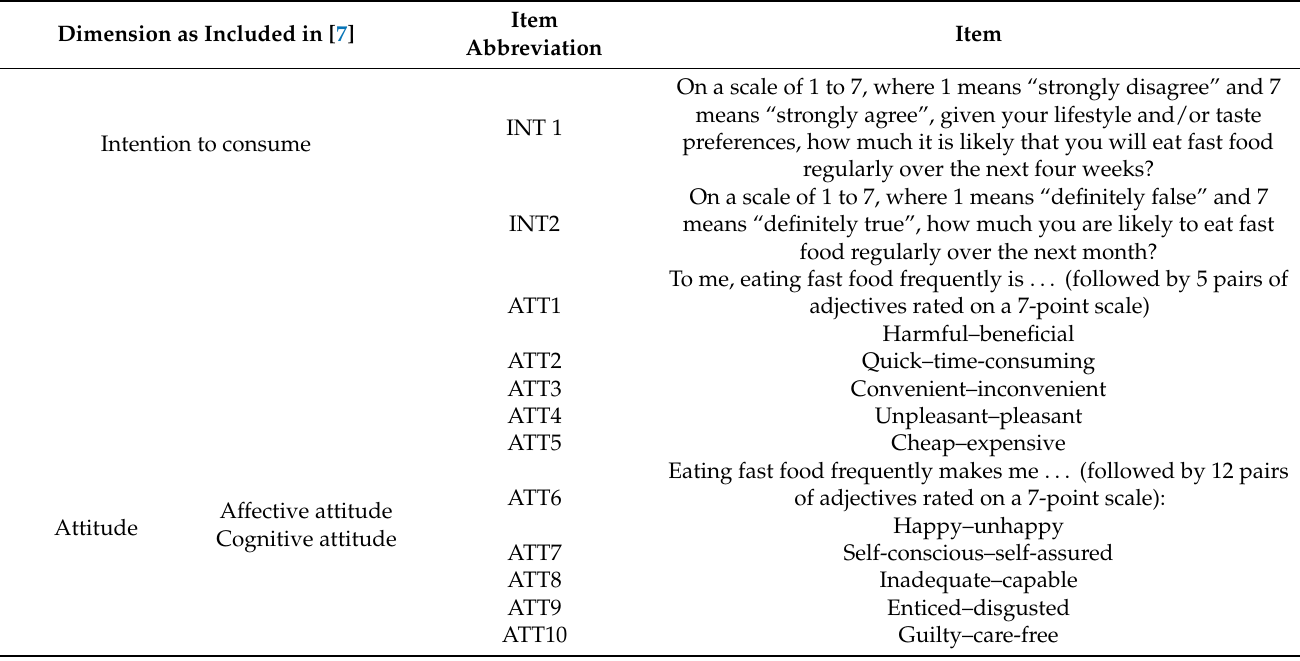
Table A1. A review of the measurement